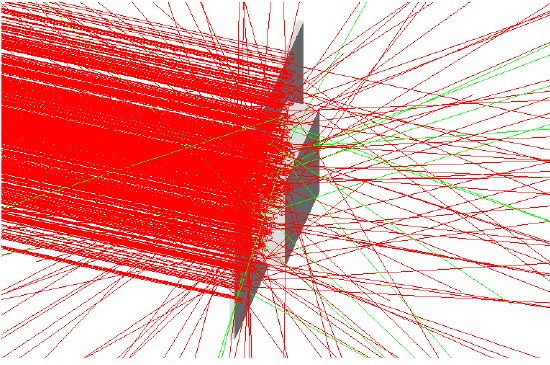
Figure 7. Geant4 simulation model and radiation process. To compare with the experiment, a 0.5 mm thick aluminum shielding layer was set in the simulation model due to the in-situ PEA configuration. In the simulation, the energies of the high-energy electrons were also set to 0.7 MeV, 1.0 MeV and 1.3 MeV, respectively, and the number of radiated electrons was 10 8 . The size of the PI sample was 10 mm × 10 mm × 3 mm, and the mesh grid size was 0.1 mm × 0.1 mm × 0.05 mm. Detailed physical parameters are shown in Table